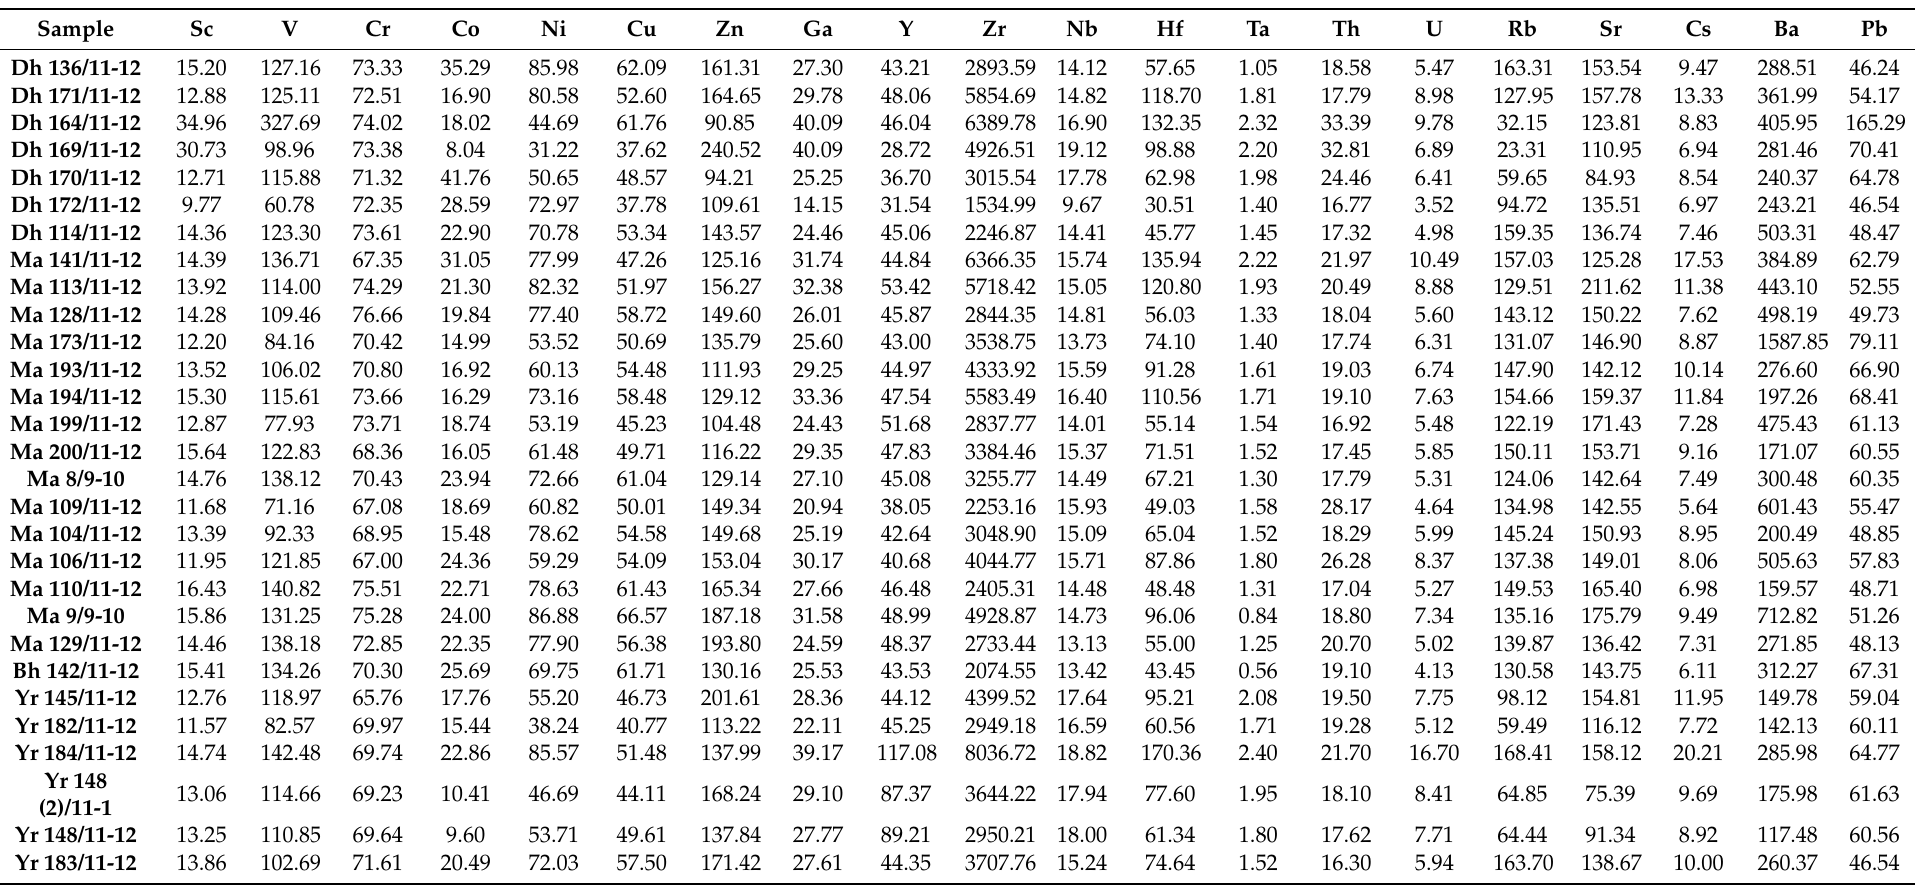
Table 5. Trace element concentration (ppm) in mudstone samples of Yerrapalli, Bhimaram, Maleri and Dharmaram